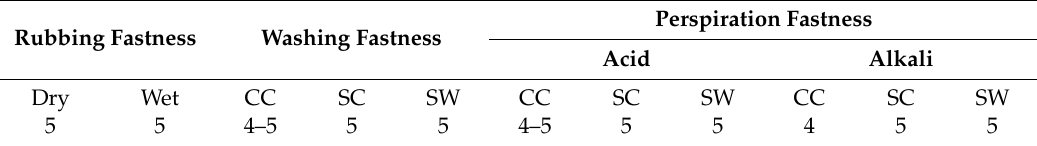
Figure 11. Bacteriostatic rates of cotton fabrics dyed under different pH values. Table 2. Color fastness of dyed cotton fabric. Table 2. Color fastness of dyed cotton